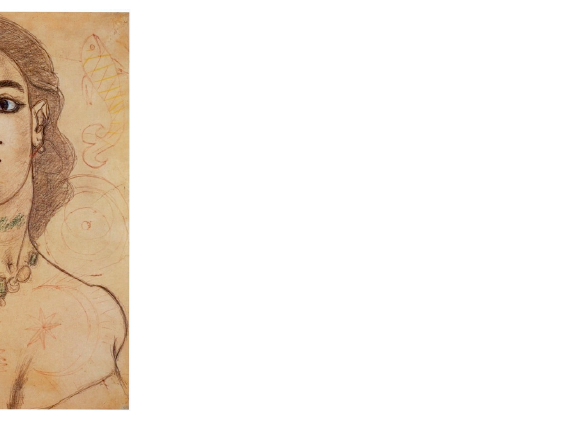
Figure 12. John Graham, Study for Two Sisters , ca. 1943, pencil and charcoal on paper, 24 × 18 3/4 in. Present location